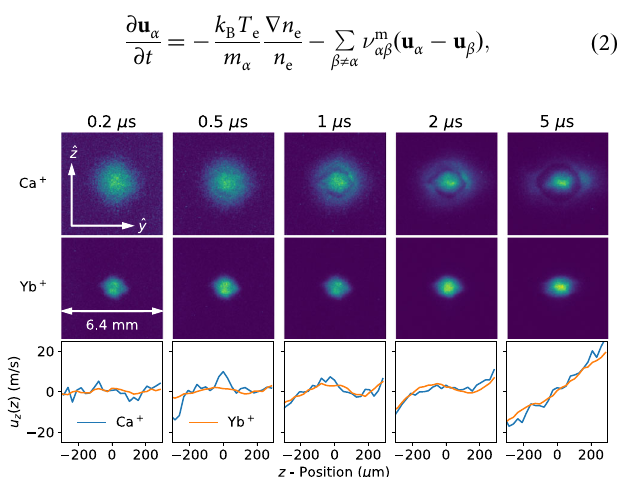
Fig. 1 Expansion dynamics for a dual-species Ca + /Yb + UNP. The top two rows show a vertical cut through the spatial density pro fi le in the center of the plasma. The top row shows the Ca + density pro fi le and the middle row shows the Yb + density pro fi le. The bottom row shows u z ( z ), the z - component of the hydrodynamic velocity u α at the time labeled in the fi gure. The frictional con fi nement of the Ca + ions and also the demonstrated hydrodynamic fl ow locking justify a uniform-density MD simulation as described in the